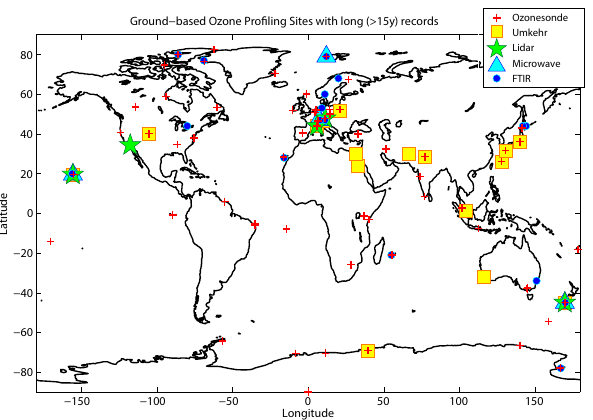
Figure 1. World map with locations of long-term ground-based measurement sites: ozone sounding sites (red plus signs), lidar sites (green stars), microwave sites (light blue triangles), Dobson/Brewer sites with Umkehr measurements (yellow squares), and FTIR sites (dark blue